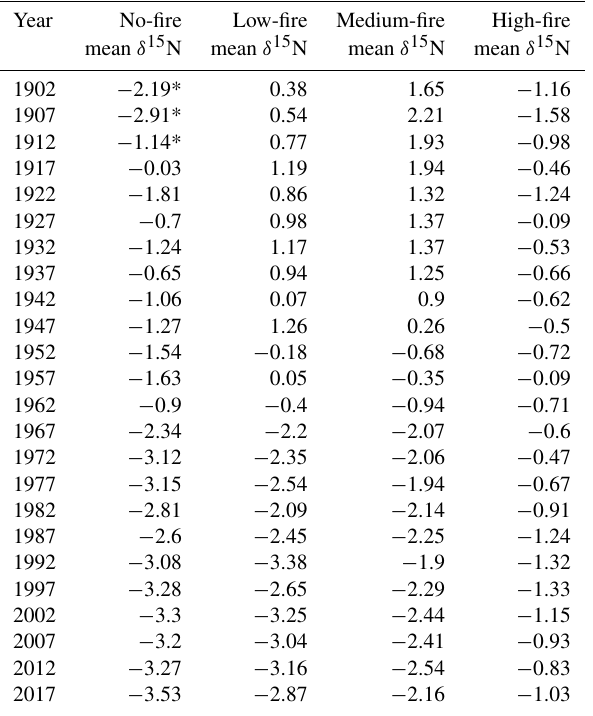
Table 3. Mean wood δ 15 N (%) by year in each burn unit. Mean values ∗ indicate years with only one δ 15 N sample in that year and burn